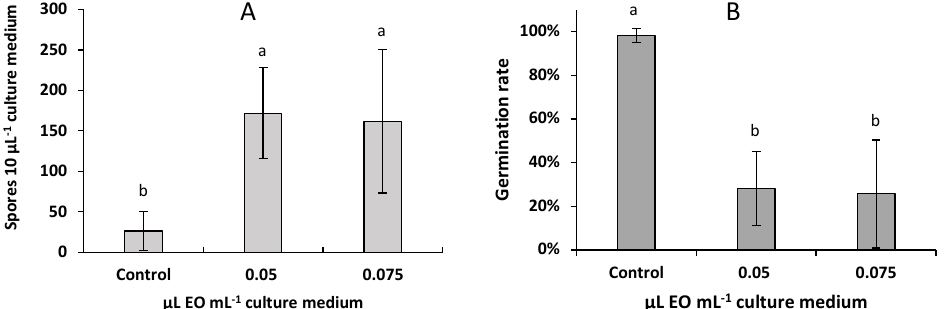
Figure 4. Changes in sporulation capacity ( A ) and rate of spore germination ( B ) after treatment with two concentrations of A. pusilla EO for 24 h. Means of 3 replicates. Errors bars are ± standard deviations. Means with the same lowercase letter are not significantly different ( p < 0.05).